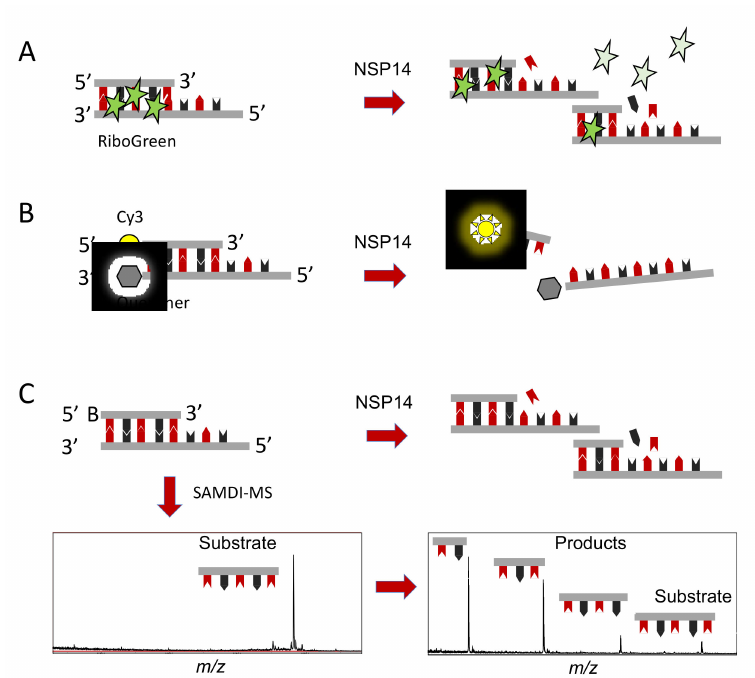
Figure 1. High-throughput biochemical activity assays for NSP14 exonuclease activity. ( A ). Double- stranded RNA is incubated with the non-specific intercalator RiboGreen. Upon nuclease activity, the RiboGreen is released, corresponding to a loss of signal. ( B ). Traditional FRET assay using dsRNA substrates featuring a fluorescent emitter, such as Cy3, and a fluorescent quencher. Upon NSP14 nuclease activity, the two strands dissociate, releasing the fluorescent emitter generating a fluorescent signal. ( C ). A dsRNA substrate featuring a biotin on the 5 (cid:48) end is digested by NSP14 exonuclease activity. The biotinylated substrates and products are immobilized onto NeutrAvidin, presenting self-assembled monolayers in a high-density biochip array format that are efficient substrates